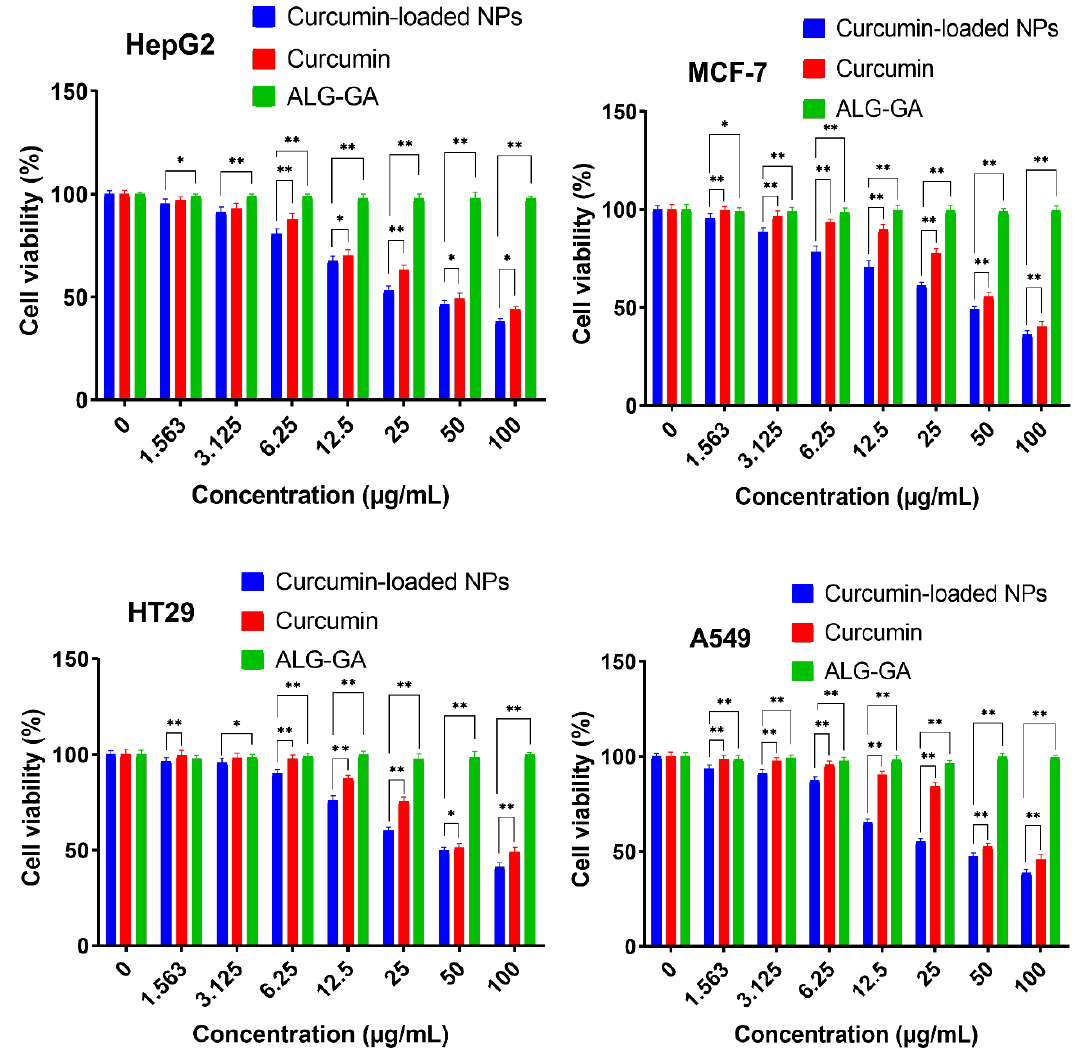
Figure 8. Cytotoxicity activity of Curcumin and curcumin-loaded NPs at different concentrations exposed to cancer cell lines (MCF7, HepG2, A549, and HT29) after 24 h. Mean ± SD of three experiments. Error bar are * p < 0.05, ** p < 0.01.